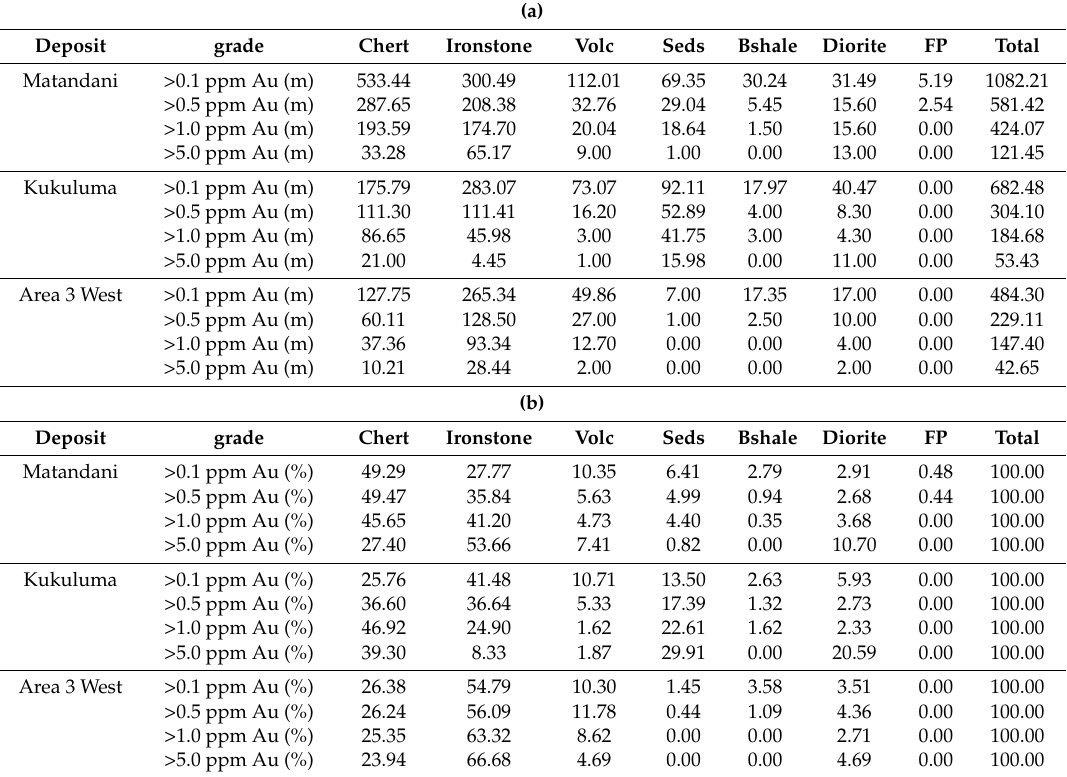
Table 2. (a) Length of logged drill core expressed in metres, listed by grade and rock type for the Matandani, Kukuluma, and Area 3 west deposits. (b) Length of logged drill core expressed in % of total, listed by grade and rock type for the Matandani, Kukuluma, and Area 3 west deposits. The lithological units listed comprise chert, including massively banded chert and highly silicified laminated sedimentary units; ironstone, referring to well-bedded, silicified, magnetite-rich units including BIF (banded ironstone formations), transitional with chert; Volc, which references volcanoclastic units including agglomerate, fragmental tuff, and ignimbrite; Seds represents sediments comprising alternating siltstone–shale units, with layers of coarser-grained sandstone, grit, and rare conglomerate; Bshale, or graphitic black shale; and Diorite, representing monzonite and diorite of the Kukuluma Intrusive